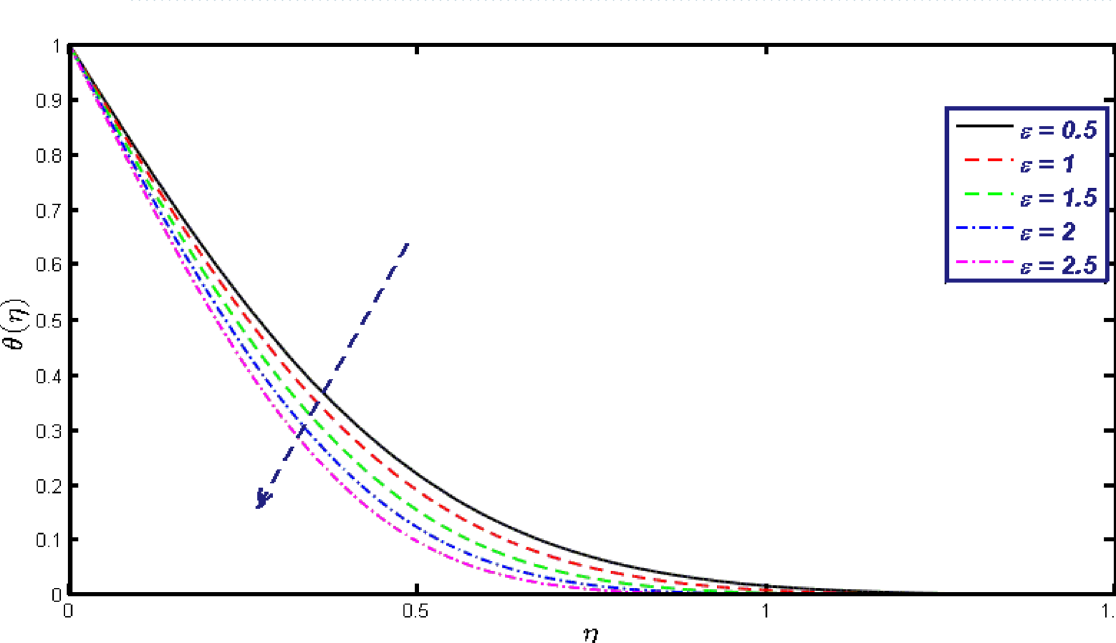
Figure 14. θ(η) field for different values of ε